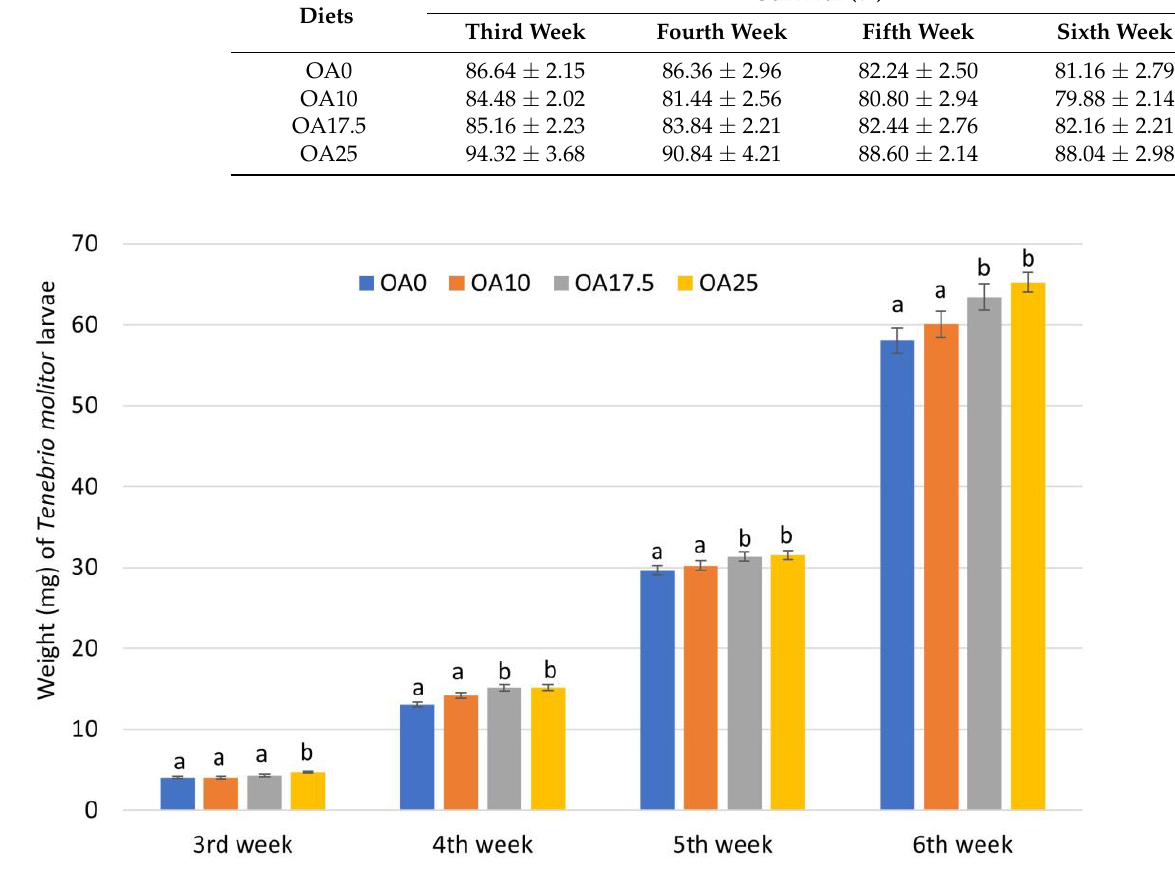
Figure 1. Individual weight (mg) of Tenebrio molitor larvae fed for six weeks with wheat bran (control) (OA0) and bran fortified with different rates of albedo orange peel waste (10 (OA10), 17.5 (OA17.5), and 25% (OA25)) (n = 8). Statistically significant differences ( p < 0.05) are denoted with different superscript